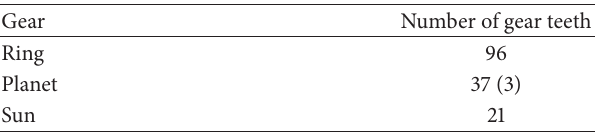
Table 5: Fixed-shaft gearbox configuration parameters. Number of gear teeth Gear Input stage Output stage Input gear 71 — Intermediate shaft gear 19 89 Output gear —